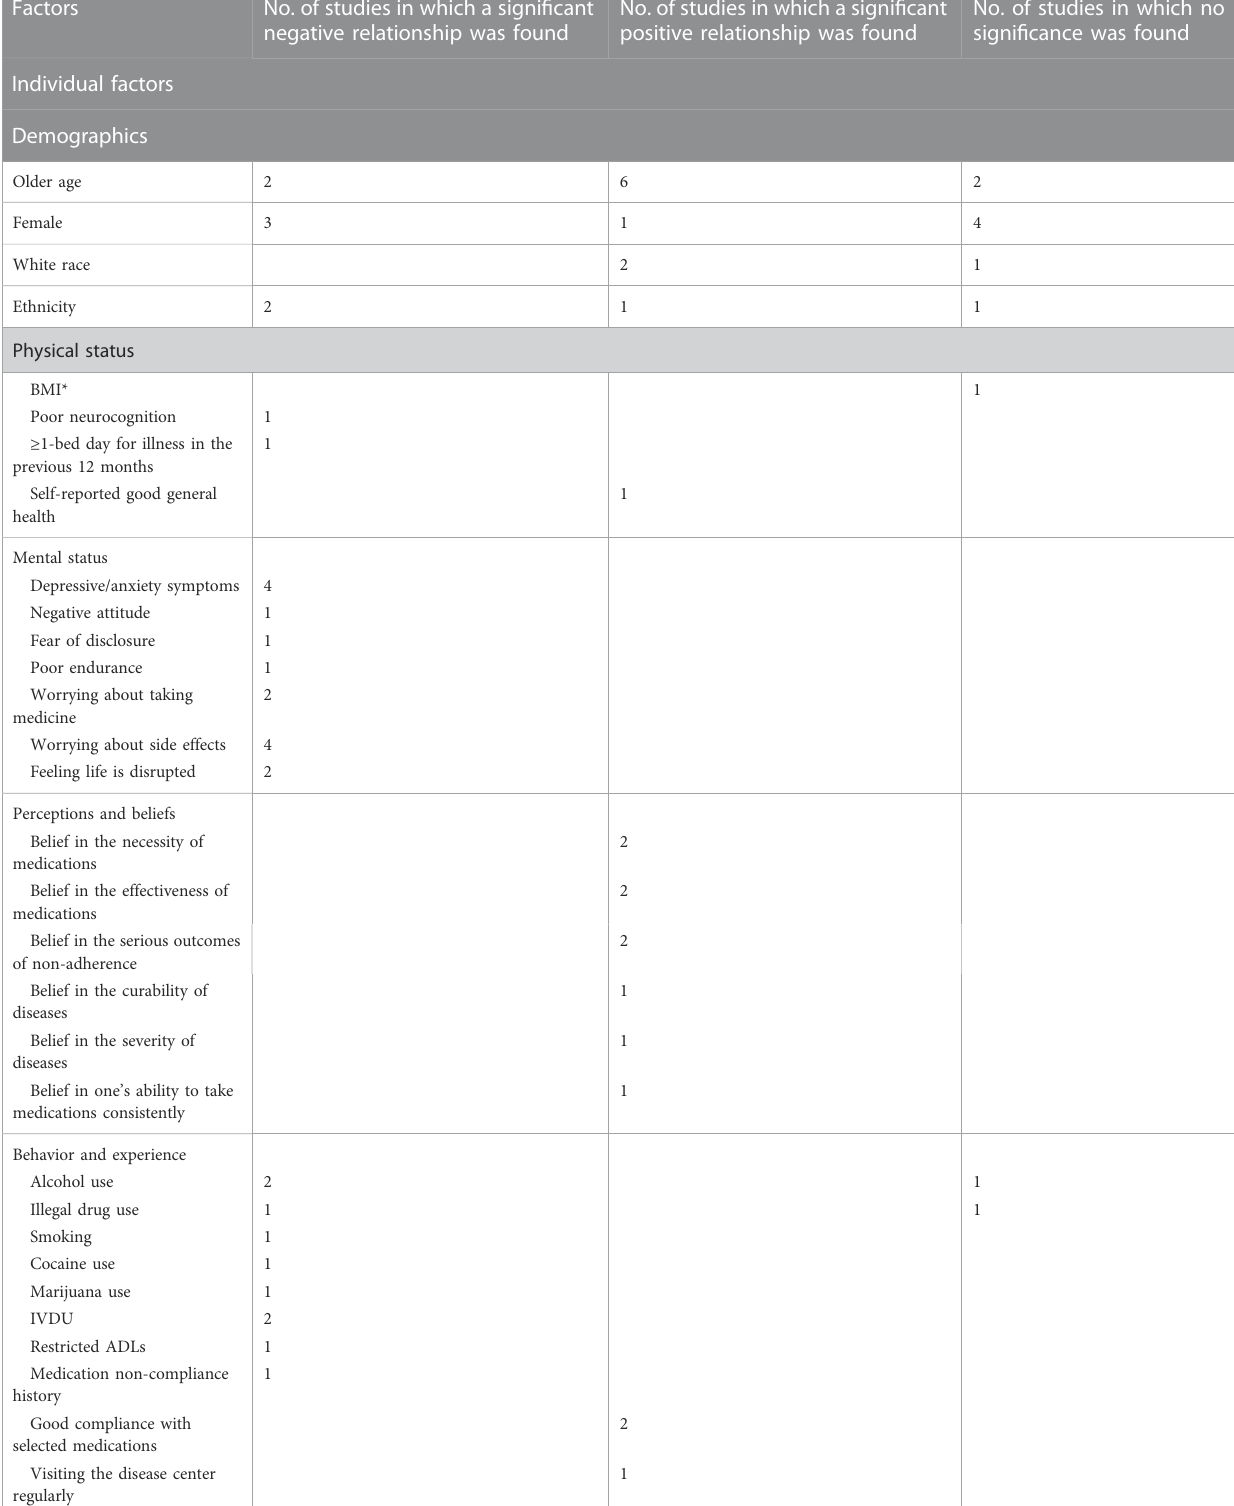
No. of studies in which a signi fi cant positive relationship was found